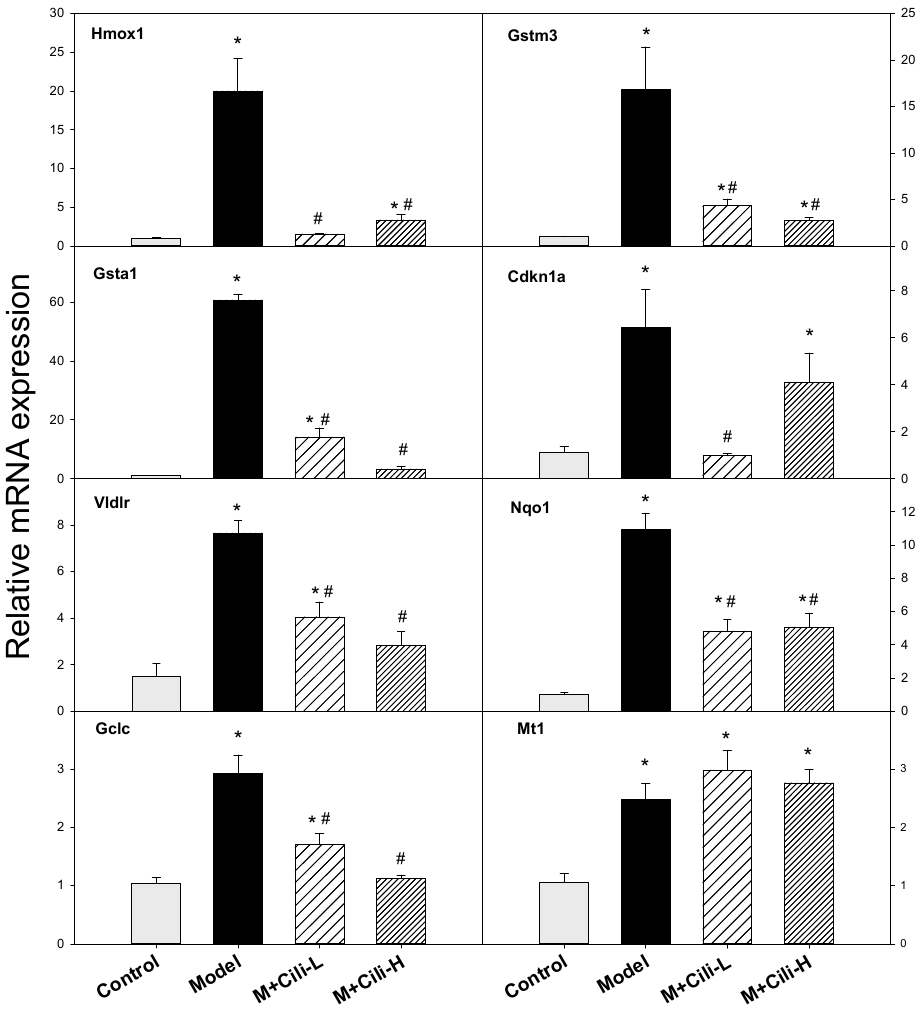
Figure 8. qPCR analysis gene expression related to oxidative damage among groups. Data are mean ± SEM ( n = 8), * Significantly different from the Control group, p < 0.05; # Significantly different from the Model group, p < 0.05.